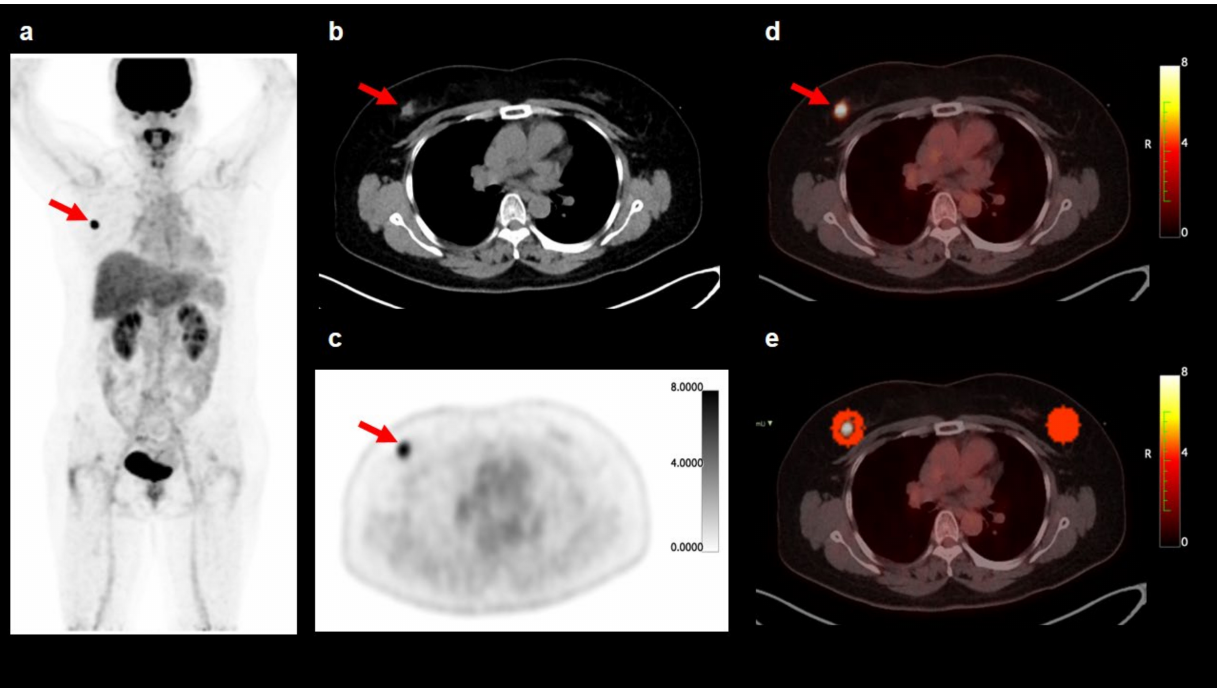
Figure 2. Maximal intensity projection image ( a ), transaxial CT image ( b ), transaxial PET image ( c ), and fused transaxial images ( d , e ) of F-18 fluorodeoxyglucose (FDG) PET/CT illustrating volumes of interest (VOIs) for measuring breast adipose tissue imaging features. A 53-year-old woman underwent preoperative FDG PET/CT for right breast cancer which was histopathologically diagnosed with invasive ductal carcinoma. The FDG PET/CT images revealed a breast cancer lesion showing increased FDG uptake with the maximum standardized uptake value of 9.39 (arrows in ( a – d )). A spheroid-shaped VOI that covers the peritumoral breast tissue within a 1 cm distance to the margin of the breast cancer lesion was manually drawn, and another VOI of the same size was drawn in the same quadrant of the contralateral breast tissue. Within the VOIs in the bilateral breast tissues, the area with CT attenuation ranging between − 200 and − 50 Hounsfield units was automatically delineated and defined as the area of the peritumoral and contralateral breast tissue ( e